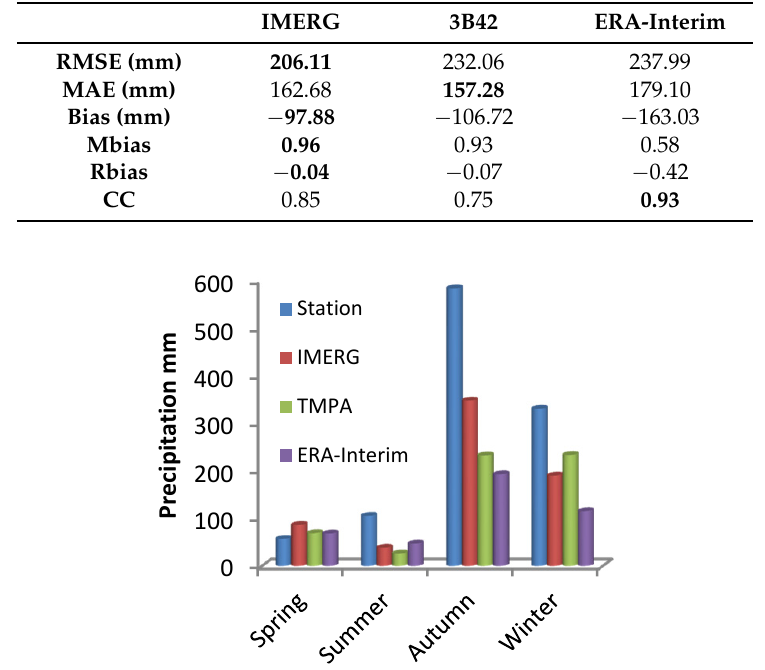
15 of 24 Figure 11. Tehran monthly precipitation (mid-March 2014 to February 2015). 5.3. Seasonal Evaluation To evaluate the seasonal precipitation rain-gauge observations with their corresponding grid points on satellites and models, all days of the corresponding seasons are compared. Based on seasonal scale, Figure 12 and Table 12 indicate that all three products tend to underestimate in all seasons except spring in the Guilan region. IMERG has a better value of Bias, RMSE, Mbias and Rbias while ERA-Interim represents significant agreement. With respect to Figure 13 and Table 13, 3B42 shows the best results in Bushehr in comparison with other data sets. IMERG and 3B42 displayed overestimates and ERA-Interim underestimates. As seen in Figure 14 and Table 14, 3B42 and IMERG tend to overestimate while ERA-Interim underestimates in the Kermanshah region. The IMERG yields a correlation coefficient of 0.95 which